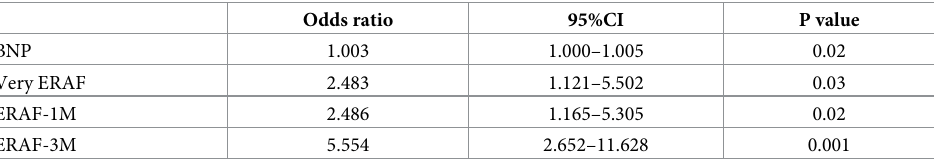
Table 6. Predictors of true AF recurrence after RF